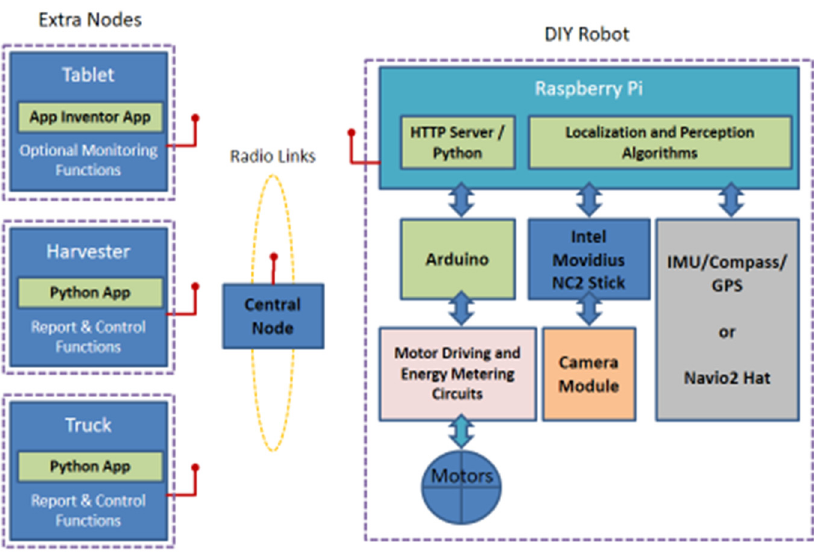
Figure 7. A typical interoperability diagram highlighting the roles of the entities used to support the autonomous vehicle’s